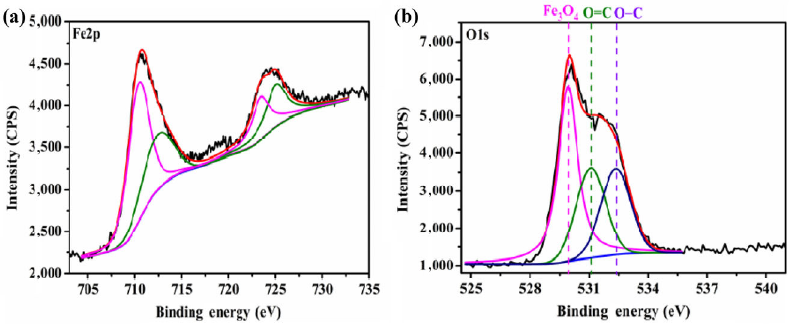
Fig. 16 Curved-fitted XPS spectra of worn steel surface under lubrication of MF at 150 ° C and 100 N: (a) Fe2p and (b)